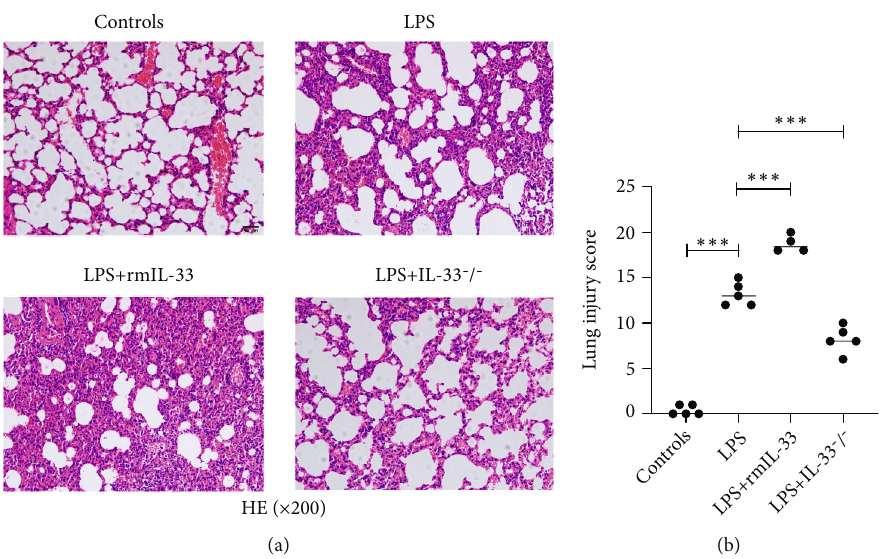
Figure 2: IL-33 de fi ciency alleviated pulmonary histopathology in mice with ARDS. (a) Representative images of HE staining of lung sections; the magni fi cation of histological images is × 200. (b) Lung injury scores were measured by the Smith method. The data are expressed as the means ± SDs . Signi fi cant di ff erences are shown by ∗ P < 0 : 05 , ∗∗ P < 0 : 01 , and ∗∗∗ P < 0 : 001 by one-way ANOVA followed by Bonferroni ’ s post hoc test comparing the WT control, LPS, LPS+rmIL-33, and LPS+IL-33 -/- groups. N = 3 ‐ 5 for each group, and three independent repeated experiments were carried